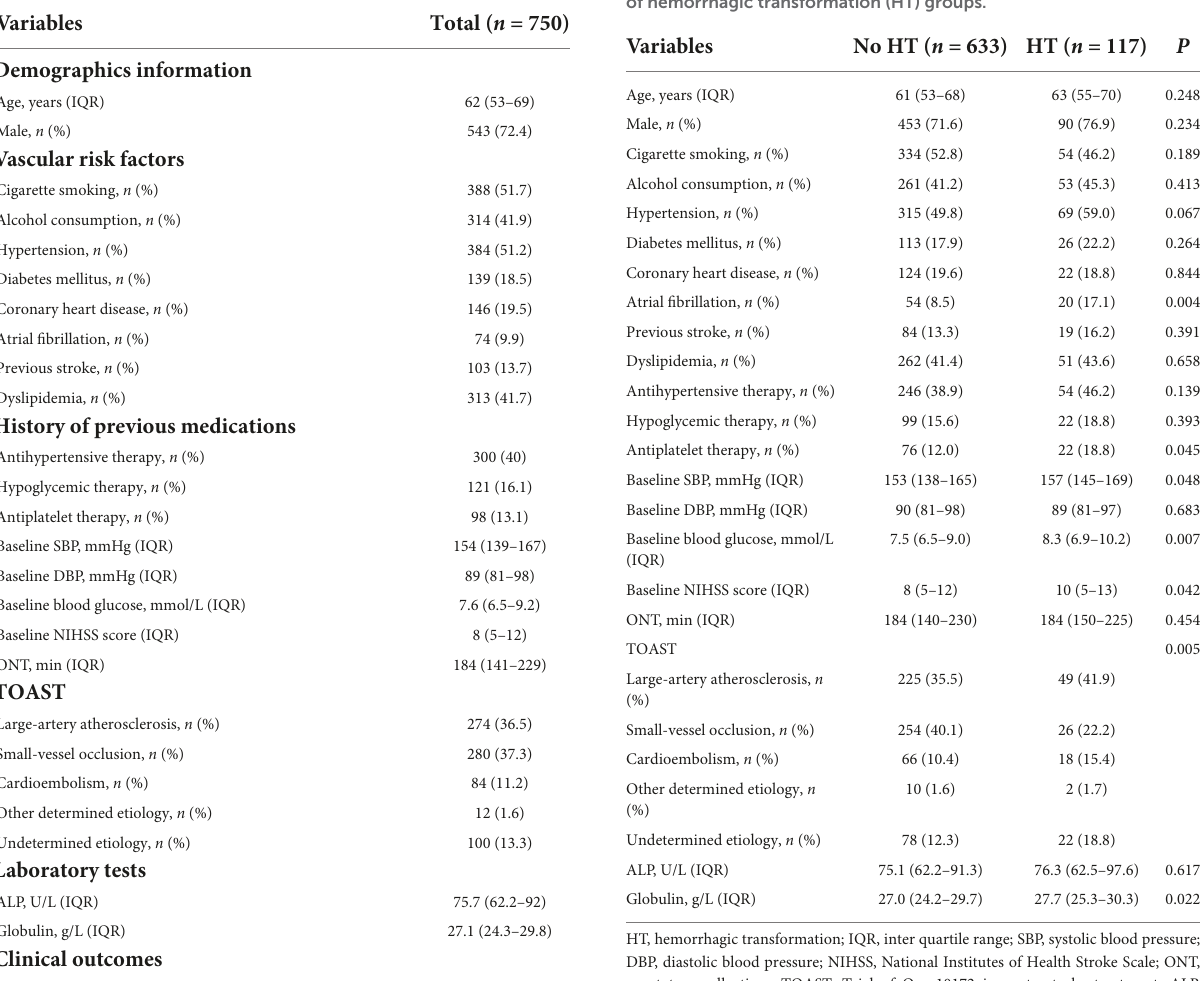
TABLE 1 Clinical characteristics of included patients. TABLE 2 Clinical characteristics of patients in the presence/absence of hemorrhagic transformation (HT)